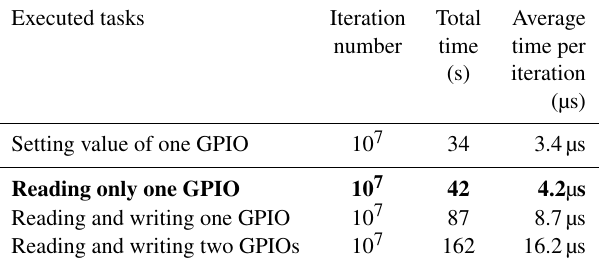
Table 1. Processing time of some tasks. In bold, the task to know the status of a GPIO.